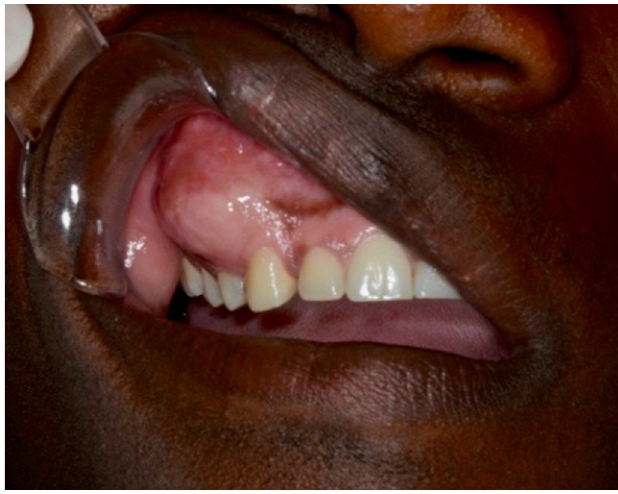
Fig. 1. Vestibular tumefaction. The recovering mucosa appears